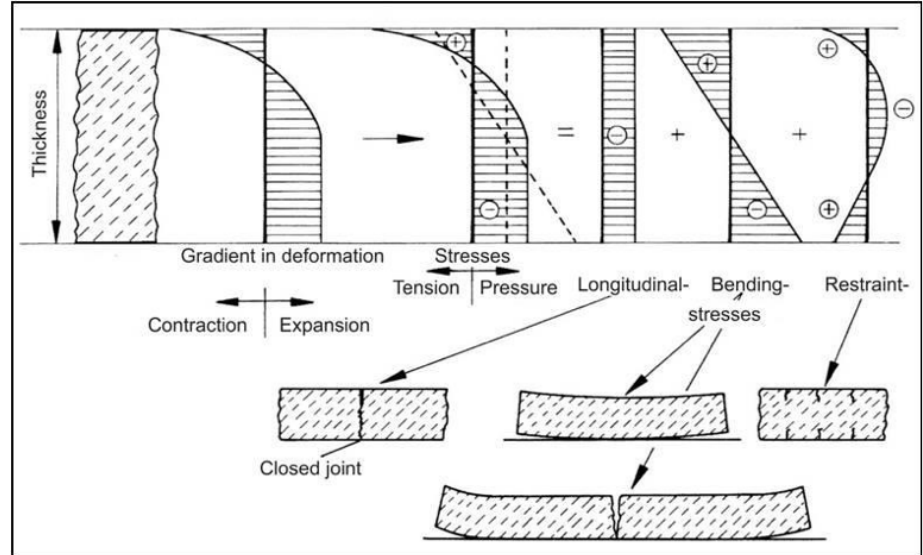
Figure 1. Stresses and cracks in concrete pavements due to negative gradients of deformation